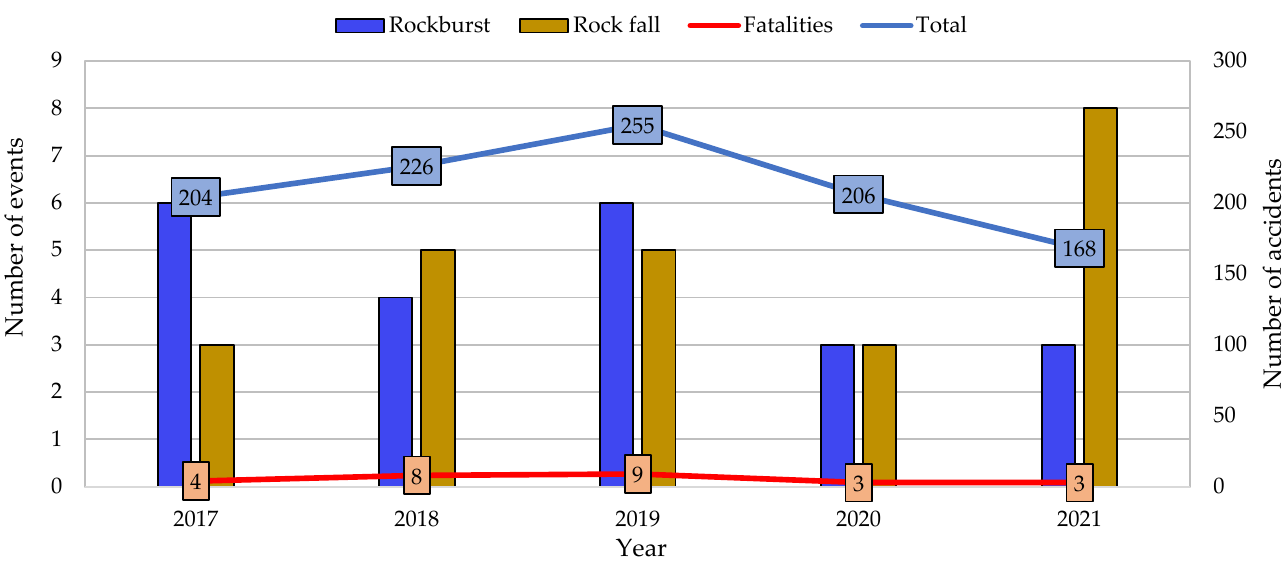
Figure 2. Number of accidents caused by rock falls and rockburst in Polish underground mines in the last 5 years.